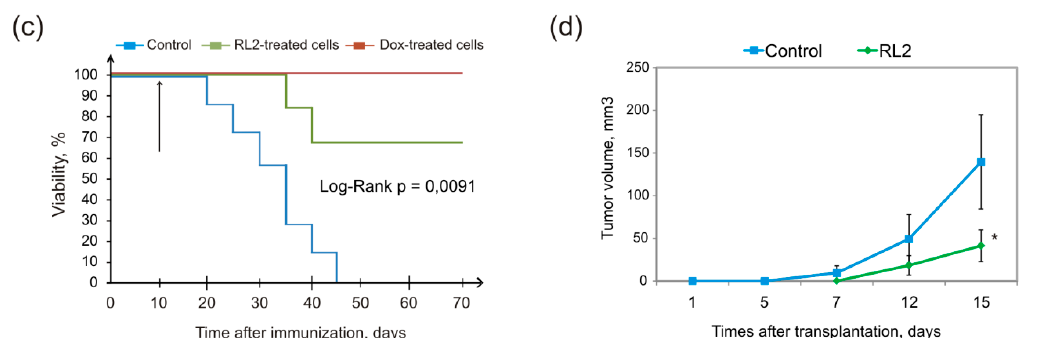
Figure 4. Immunization of C3H/He mice with MX-7 cells treated by recombinant lactaptin analog RL2. ( a ) Scheme of immunization. Syngeneic mice were s.c. immunized with RL2- or Dox-treated MX-7 cells (7 * 10 5 cell/animal). Eight days later, the mice were challenged s.c. on the opposite flank with 7 * 10 5 live MX-7 cells. ( b ) Dynamics of live and tumor-free mice in groups. ( c ) Viability of vaccinated mice. ( d ) Dynamic of tumor growth. The differences in tumor-free mice between groups were calculated using non-parametric statistics, the Pearson ′ s chi-square test, and these were significant with p < 0.05. Kaplan–Myer survival curves and Log-Rank statistics were calculated using GraphPad Prizm Software (San Diego, CA, USA).